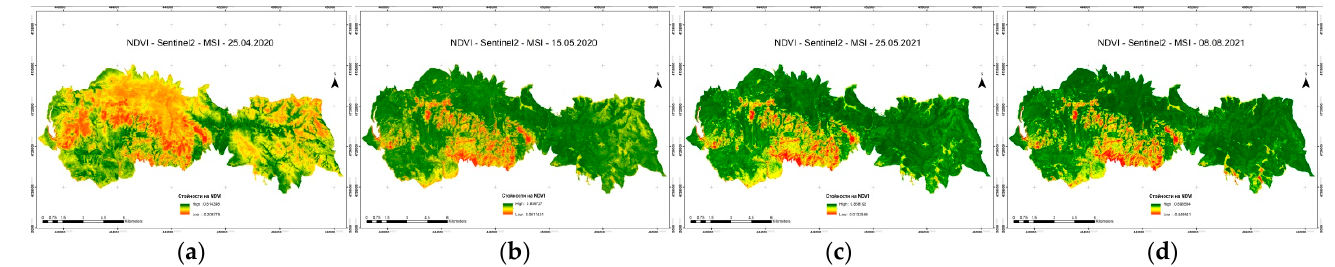
Figure 3. Maps of NDVI values from: ( a ) 25 April 2020; ( b )15 May 2020; ( c ) 25 May 2021; ( d ) 08 August 2021 .